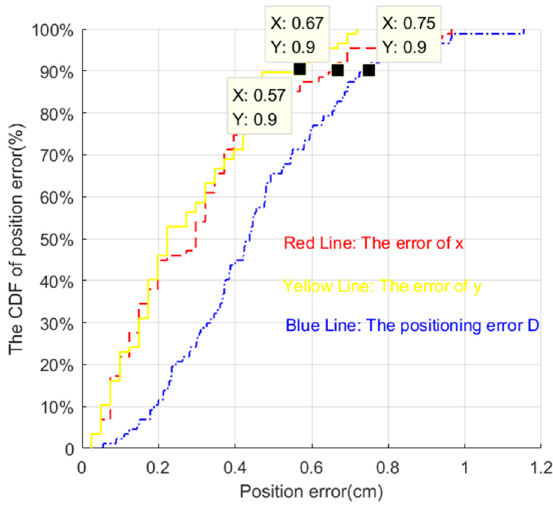
Figure 15. The cumulative distribution function (CDF) of positioning error.